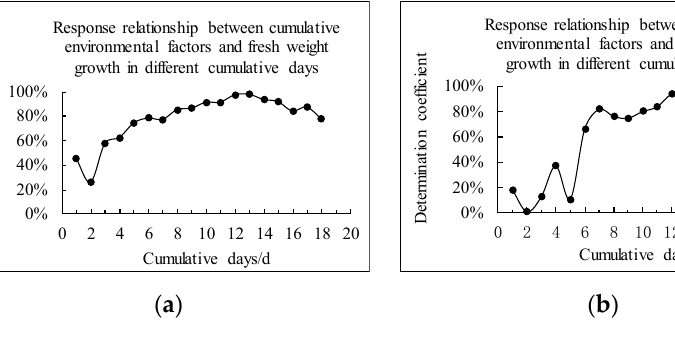
Figure 7. The response relationship between cumulative environmental factors and fresh weight growth among the samples in different batches. ( a ) Samples from the first batch, ( b ) samples from the second batch, ( c ) samples from the third batch.